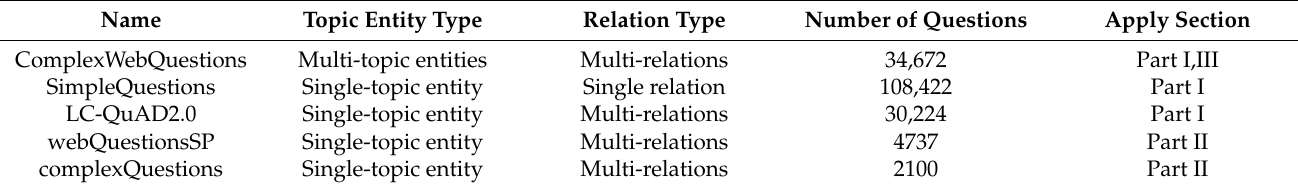
Table 2. Experimental